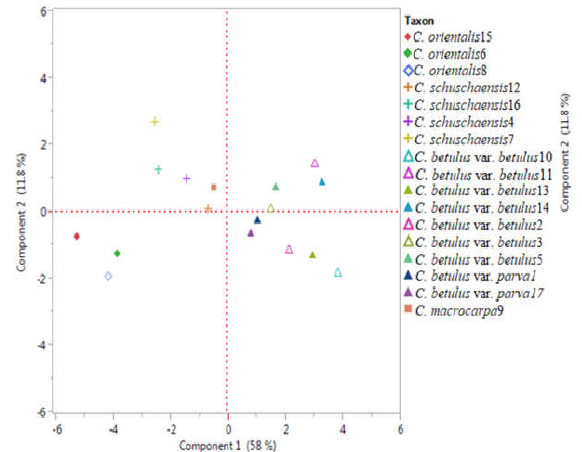
Fig. 3. Principal component analysis of the